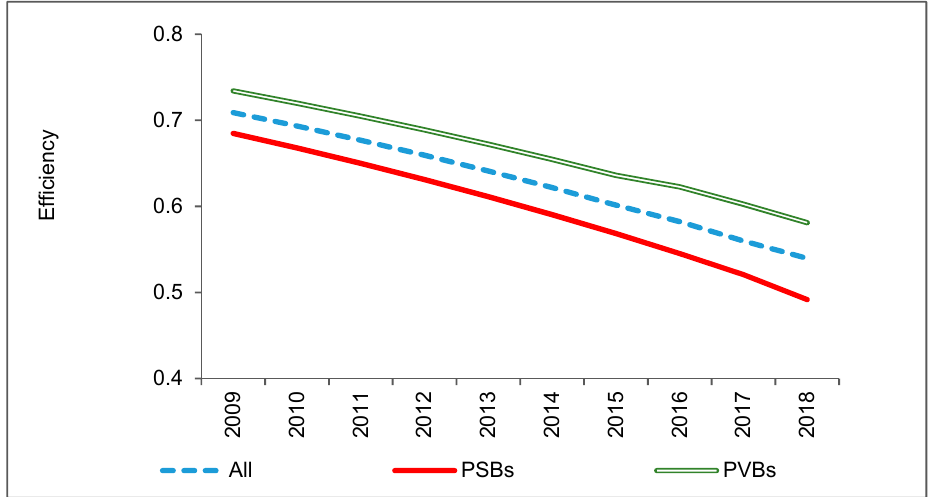
Figure 2. Bank group–mean efficiency . Source: Author’s calculation.